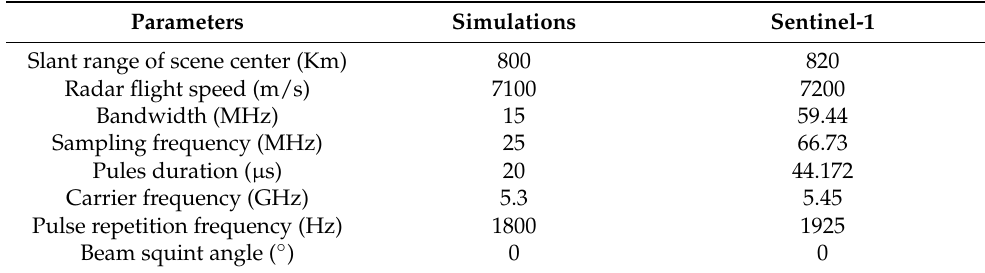
Table 1. Main parameters of radar